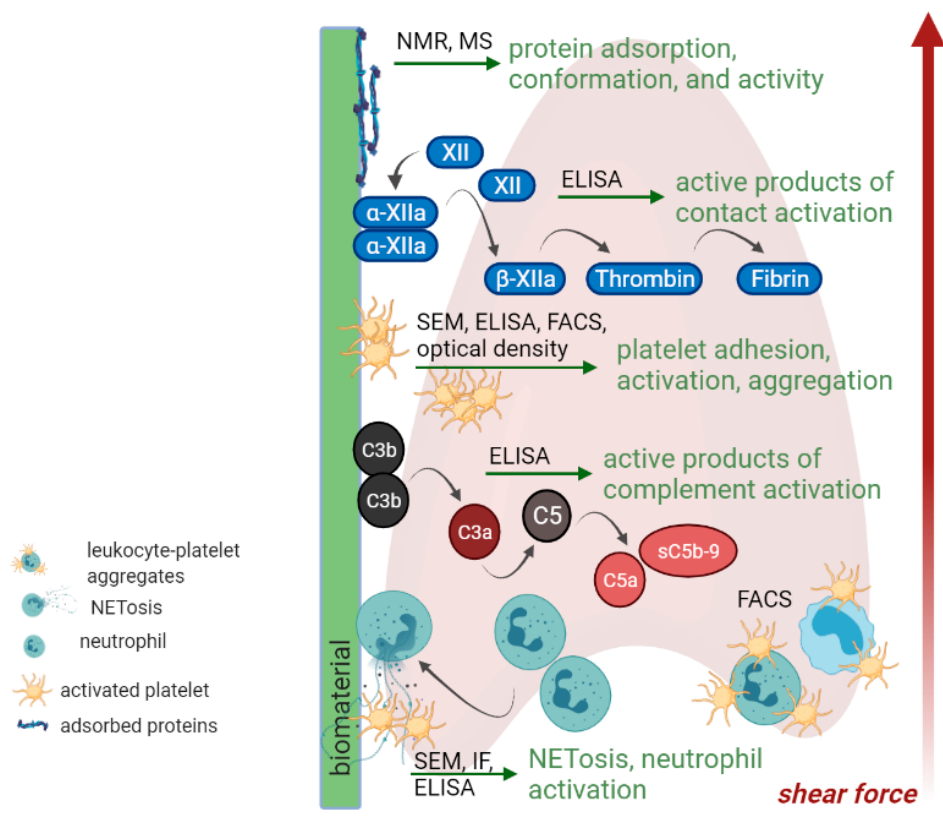
Figure 3. In vitro testing strategies: overview of targets and techniques to assess blood compatibil- ity of biomaterials. Created with